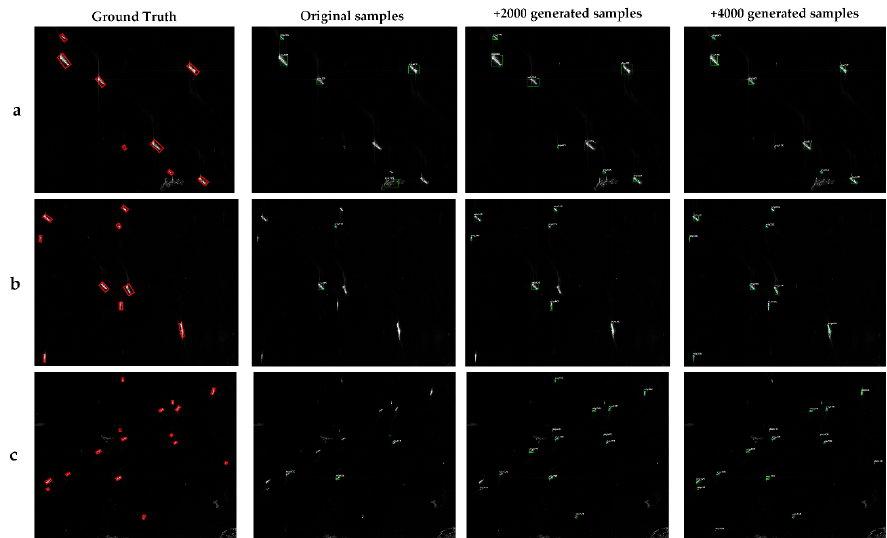
Figure 8. Detection results of ( a ), ( b ), ( c ) SAR images using Yolo v3 model trained by different sample sets. Table 4. Statistics of Yolo v3 detection results.